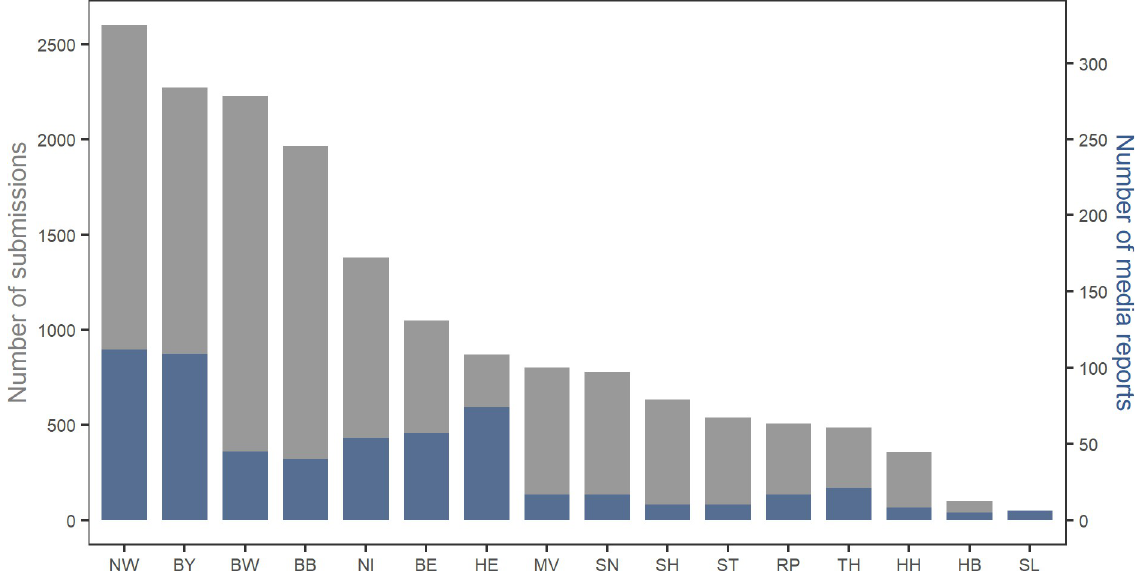
Fig 4. Numbers of submission (left y-axis) and media reports (right y-axis) by federal state. (NW = North Rhine-Westphalia, BY = Bavaria, BW = Baden-Wuerttemberg, BB = Brandenburg, NS = Lower Saxony, BE = Berlin, HE = Hesse, MV = Mecklenburg-Western Pomerania, SN = Saxony, SH = Schleswig-Holstein, ST = Saxony-Anhalt, RP = Rhineland-Palatinate, TH = Thuringia, HH = Hamburg, HB = Bremen, SL = Saarland). Spearman’s correlation coefficient shows a highly positive correlation (r s = 0.878, p < 0.001).